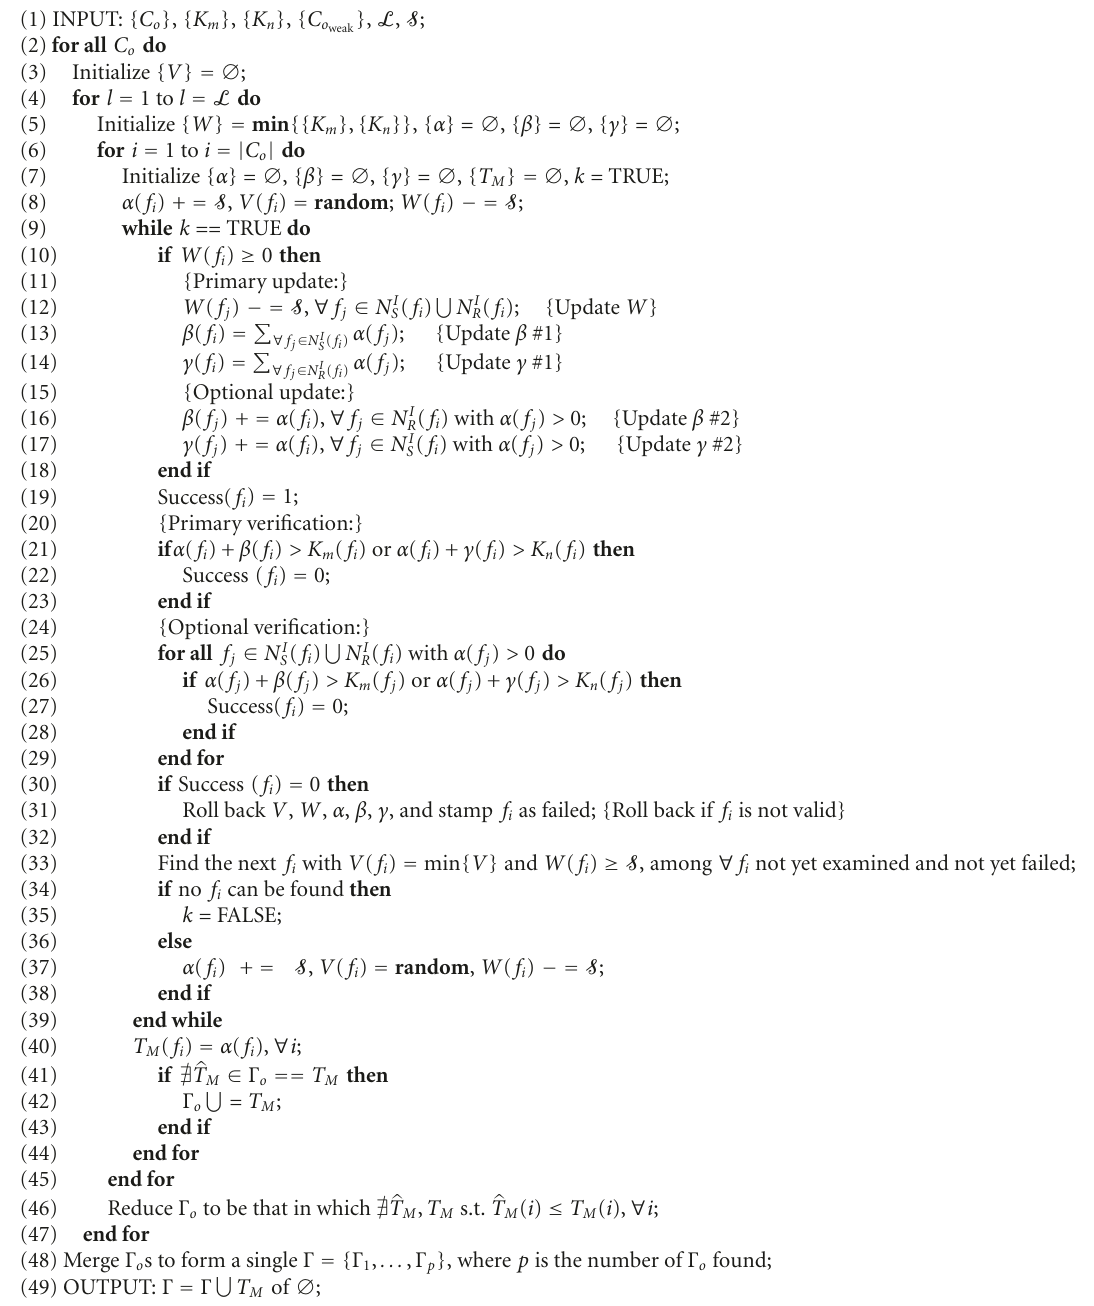
Algorithm 2: Transmission mode generating Algorithm 2